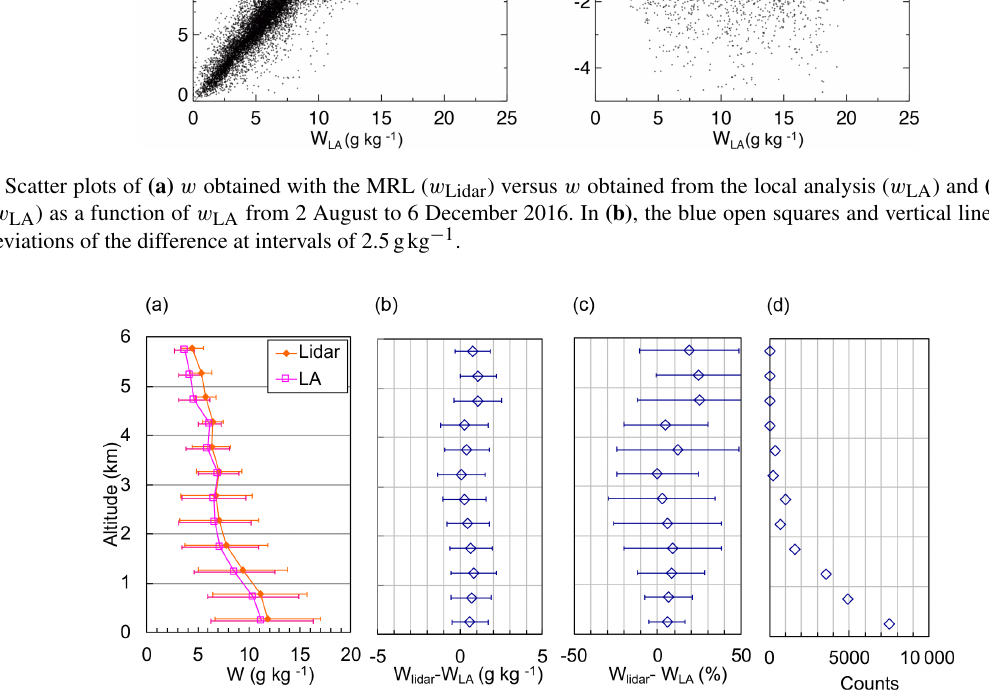
Figure 15. Vertical variations in (a) mean values and standard deviations of w obtained with the MRL ( w Lidar ) and from the local analysis ( w LA ) at 500m intervals and their (b) absolute and (c) relative differences from 2 August to 6 December 2016. Symbols and error bars in (b) and (c) show the means and standard deviations of the difference. (d) The number of data points at each